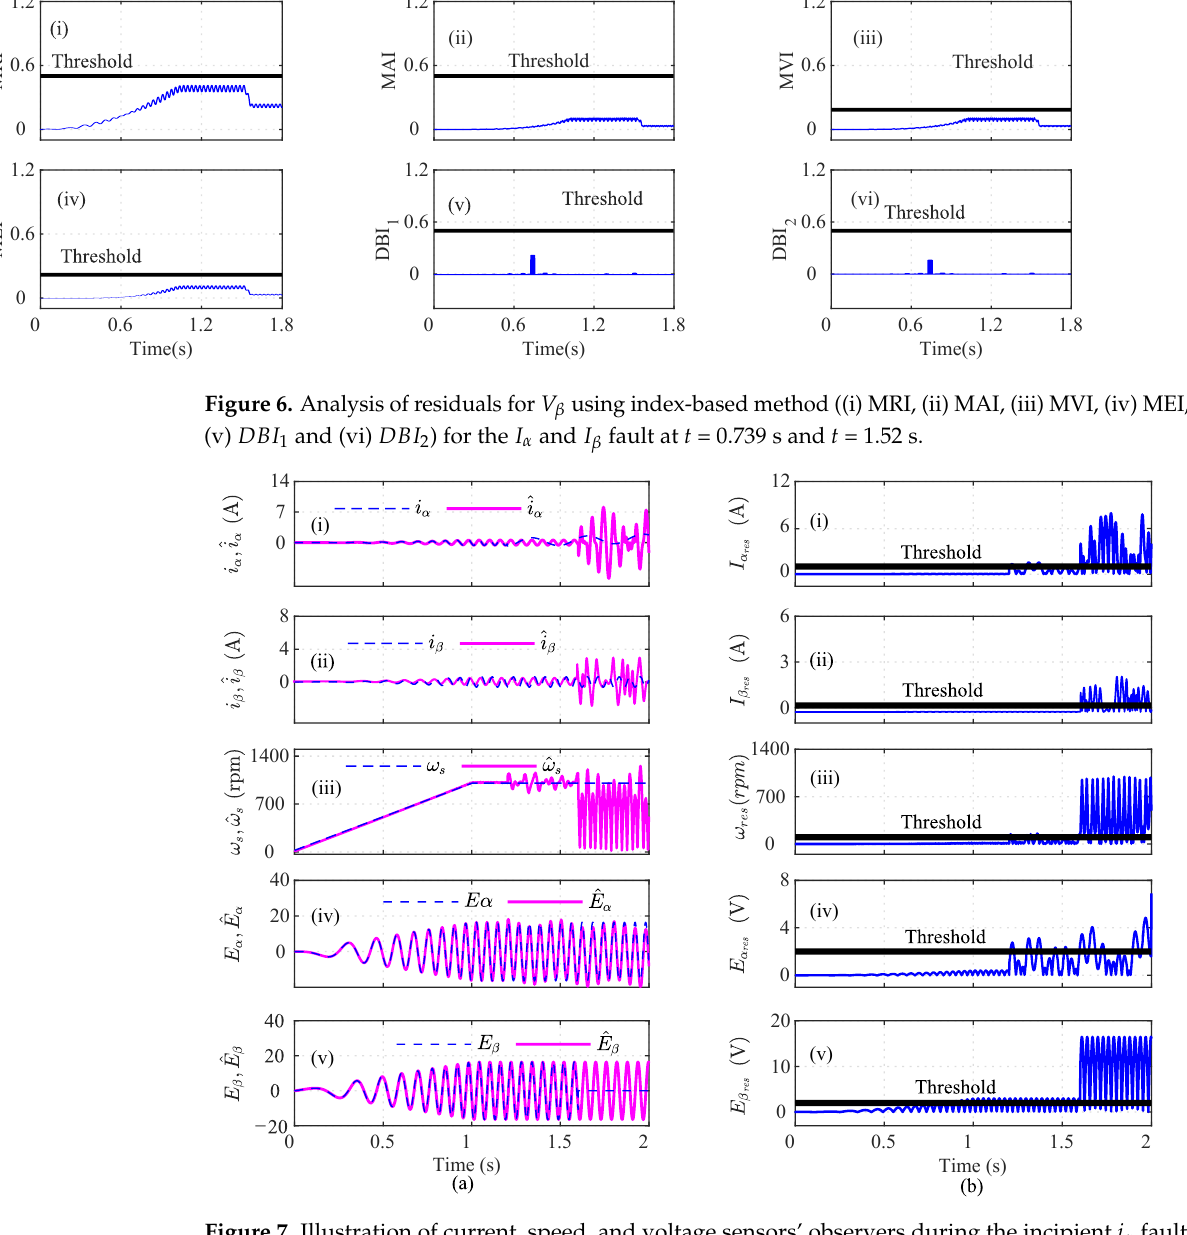
Figure 7. Illustration of current, speed, and voltage sensors’ observers during the incipient i α fault and abrupt V β fault scenario at t = 1.256 s and t = 1.60 s, respectively; ( a ) actual and estimated signals; ( b )